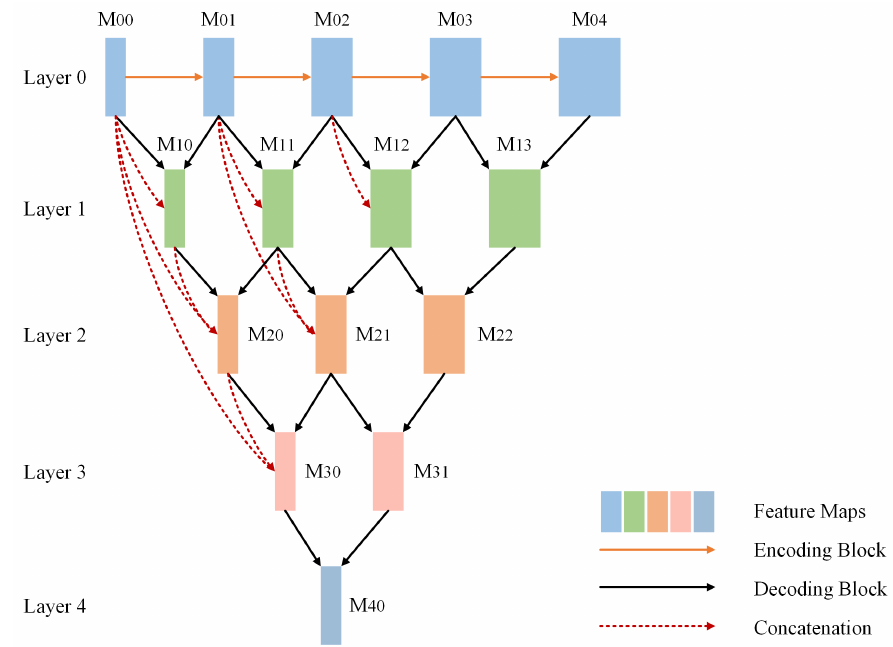
Figure 2. Architecture of dense decoding mechanism in the